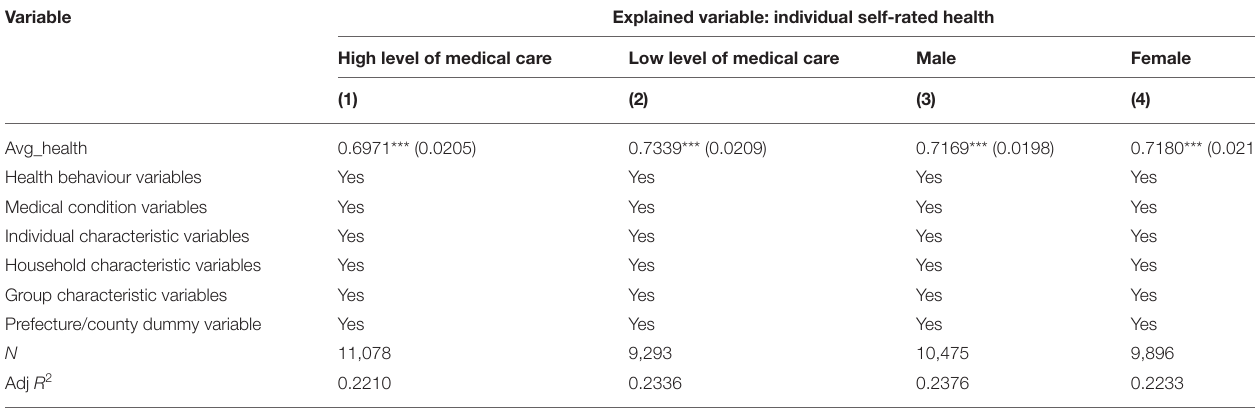
TABLE 7 | Regression results for health contagion based on differences in medical care level and gender.